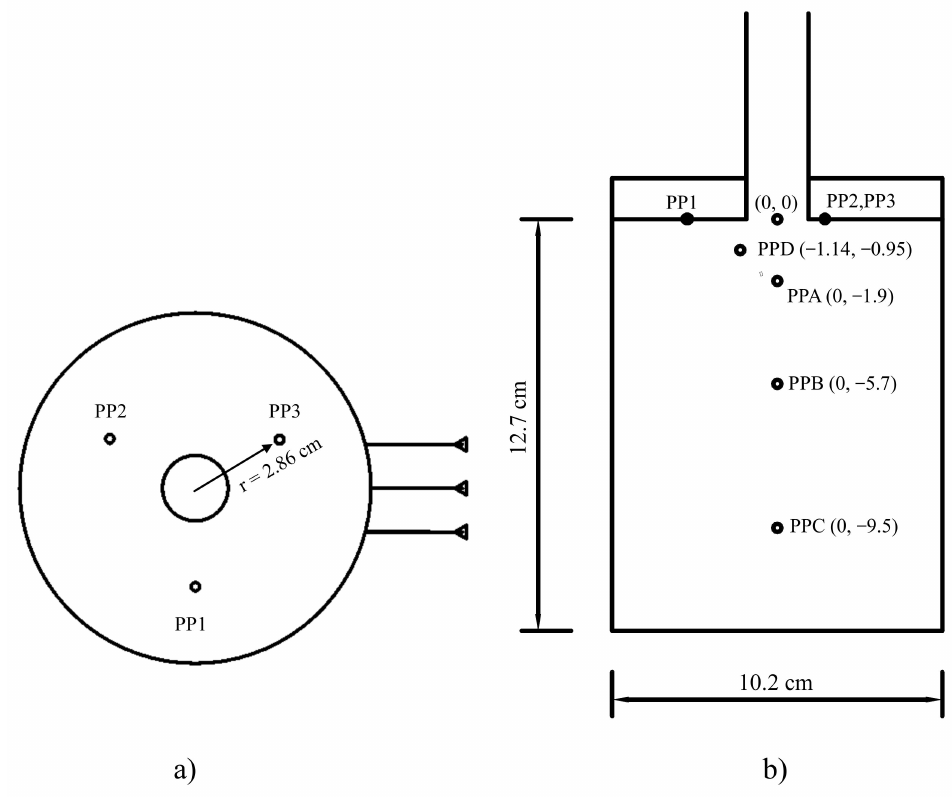
Figure 3. Locations of pore pressure ports within the sample holder: ( a ) Top view and ( b ) Side view. Soil Tested . Tests were performed on three sandy soils: (1) graded Ottawa sand (well- rounded silica sand) conforming to ASTMC778-03 [26], (2) angular silica sand with identical gradation matching that of the graded Ottawa sand, and (3) uniform, fine-grained (No. 100 sieve) garnet sand, and (4) zirconium-oxide beads with identical gradation matching that of the graded Ottawa sand. Therefore, the test soils vary in shape, gradation and size and that has satisfied the diversity of soils for analysis. A summary of critical properties and characteristics for all four soils tested is provided in Table